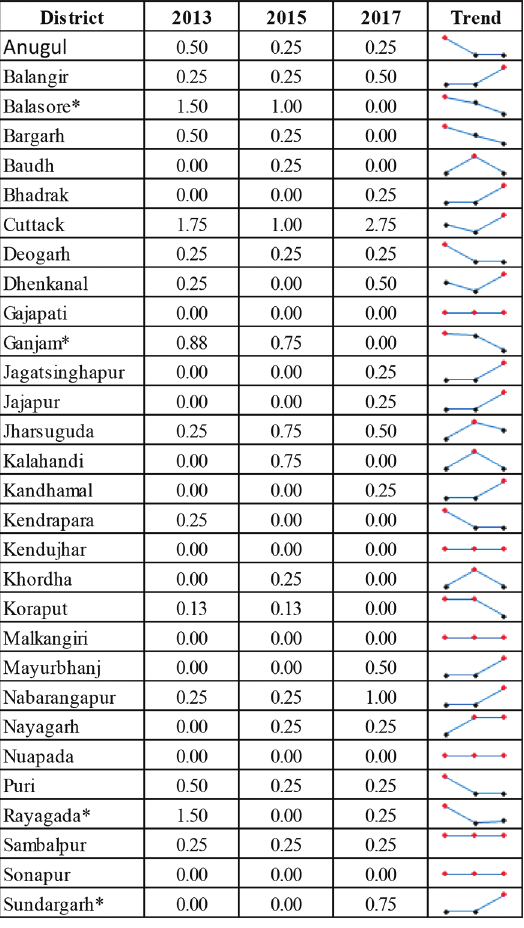
Table 2: District-wise HIV Prevalence among ANC Population in Odisha last 3 rounds of the HIV Surveillance